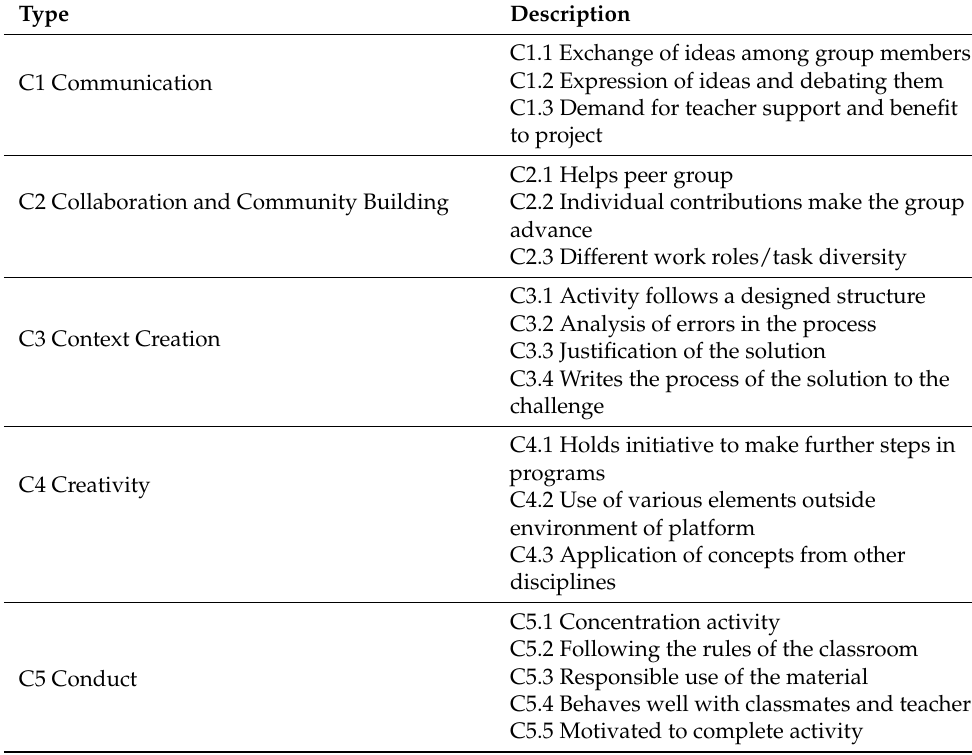
Table 2. Aspects of competences evaluated.